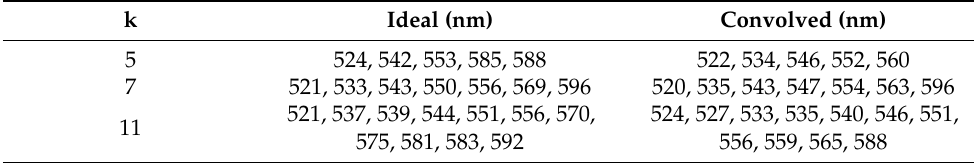
Figure 5. Simulated absorption spectra for the ideal (left) and convolved (right) cases for ( a ) low melanin (<0.10) and ( b ) high melanin (>0.30) concentrations. Each plot shows example spectra for low (<0.60, blue), medium (0.60–0.80, green), and high (>0.80, red) SO 2 values. Note that the separations between the curves near the higher wavelength lobe is greatly diminished for the convolved case relative to the ideal case. Table 3. Example wavelength